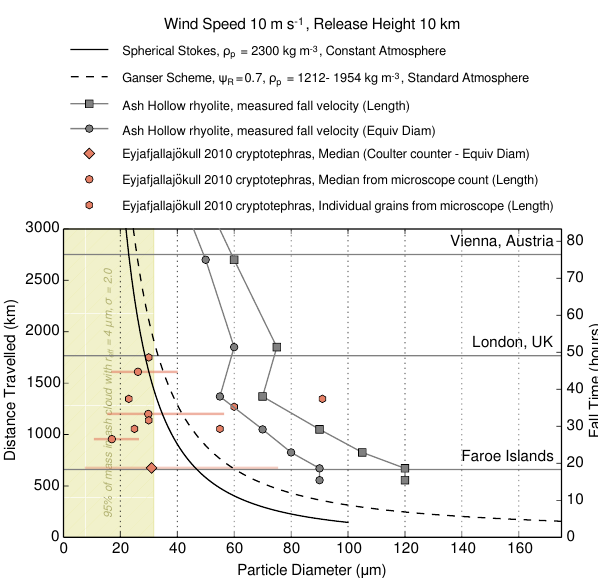
Figure 6. Modelled travel distance of ash particles as a function of particle diameter. The grey horizontal lines represent the distances from Eyjafjallajökull to various European locations. Measured par- ticle sizes from the Eyjafjallajökull 2010 eruption are plotted for comparison. Horizontal coloured bars extend from the 10th to the 90th percentiles of the PSDs. The shaded region indicates the 95th percentile size range implied by an r eff of 4µm and σ of 2.0.